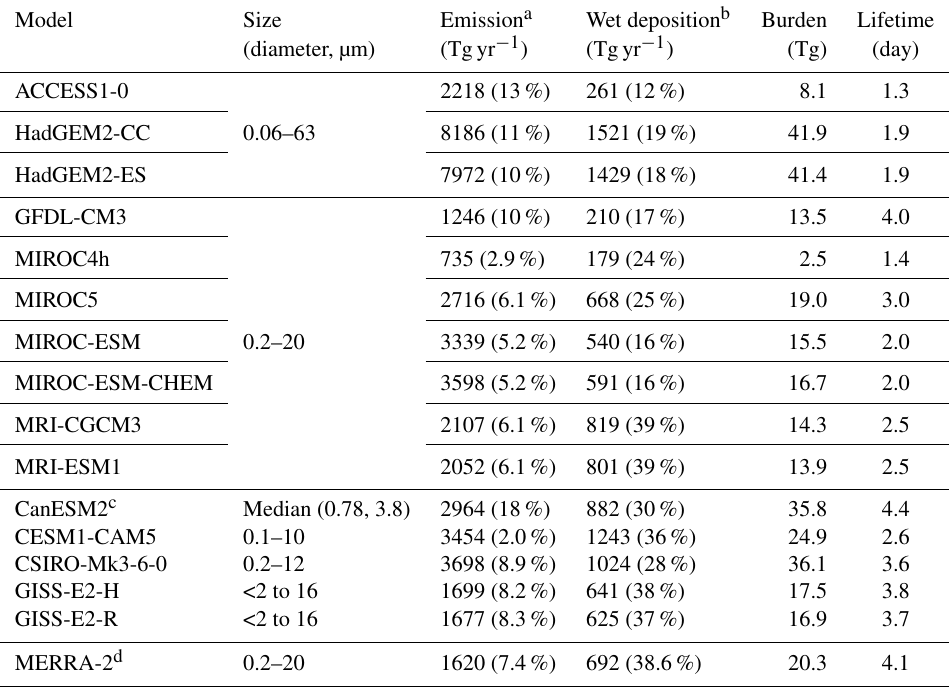
Table 3. Global dust budgets in CMIP5 models. The models are classified into three groups according to the dust size range considered. Also included for comparison is the MERRA-2 reanalysis.